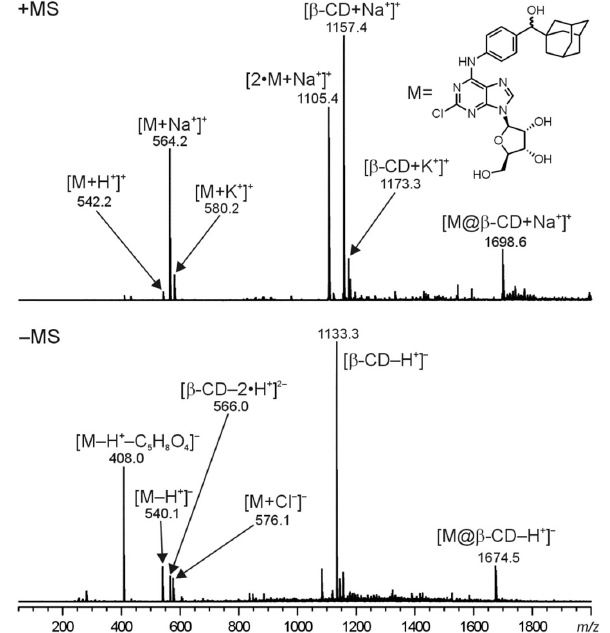
Figure 4. Positive and negative-ion ESI mass spectra of the equimolar mixture of 24 · β -CD. The assignments for the observed ions are shown in the brackets.